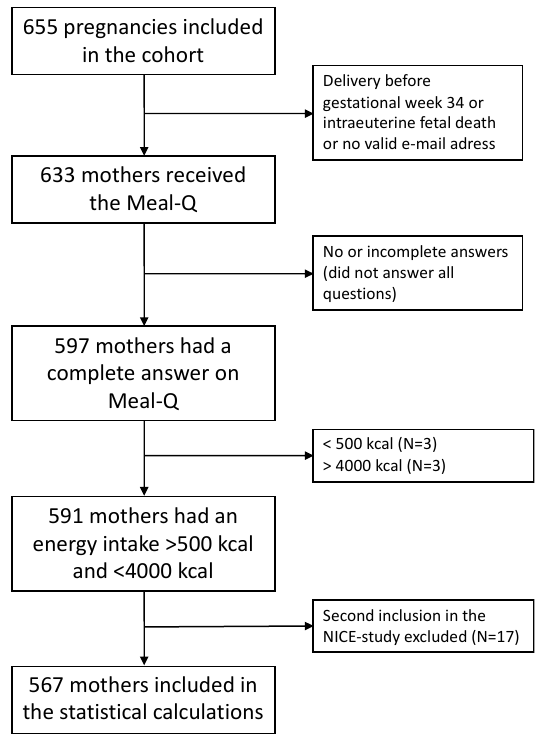
Figure 1. Flowchart regarding the inclusion and exclusion of subjects in the study.